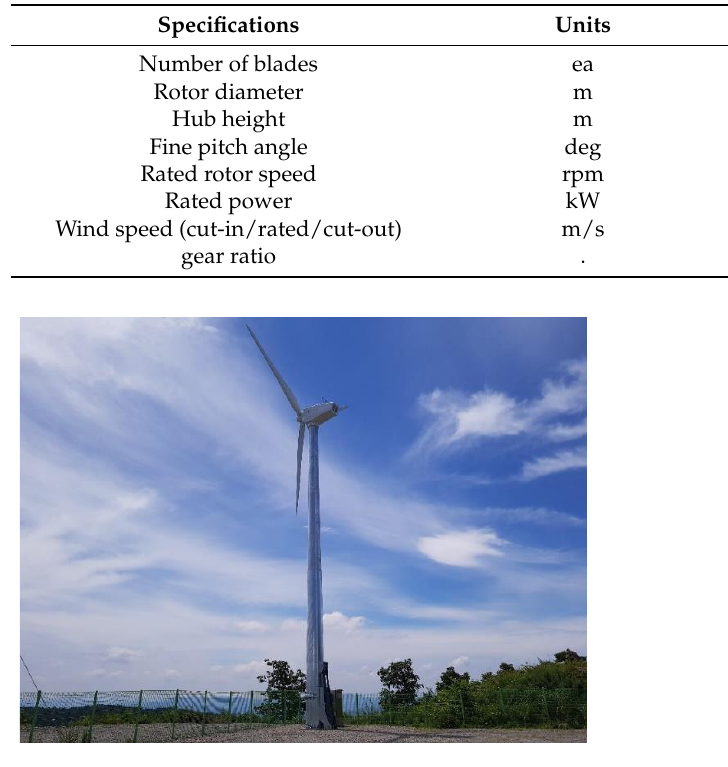
Figure 1. Photo of 20 kW wind turbine.